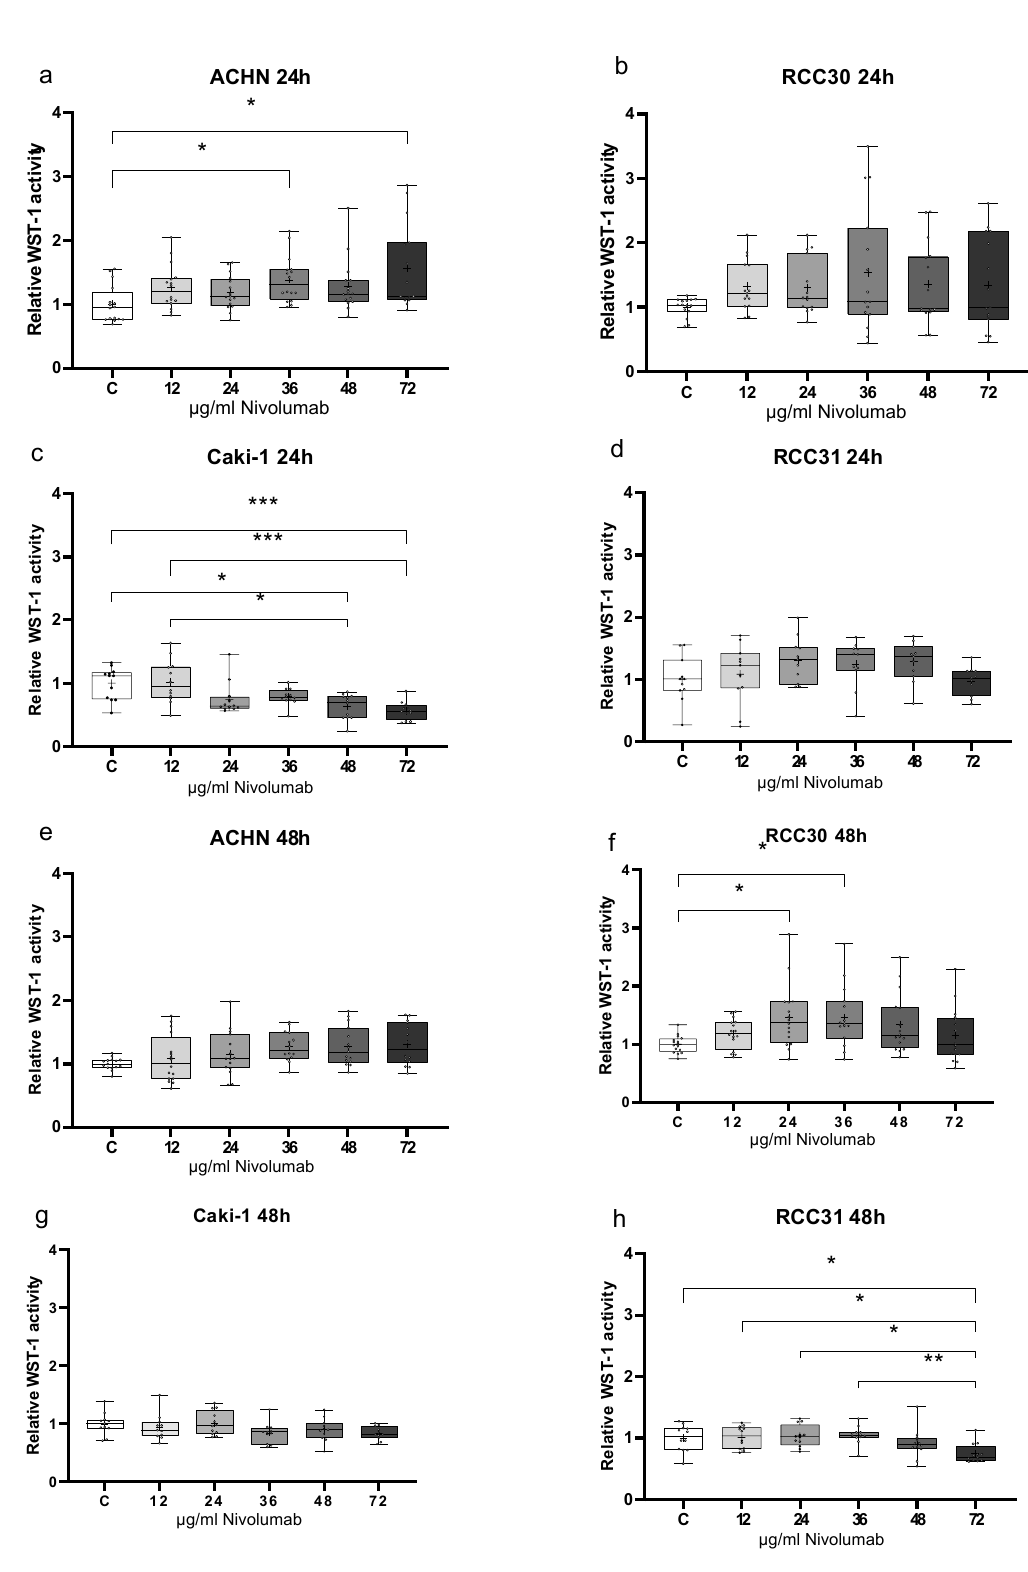
Figure 3. Metabolic activity of renal carcinoma cell lines. WST-1 activity was measured after 24 h ( a – d ) and 48 h ( e – h ) in papillary ( a , b , e , f ) and clear cell ( c , d , g , h ) renal carcinoma cells. * ≤ 0 . 05, ** ≤ 0.01, *** ≤ 0.001.